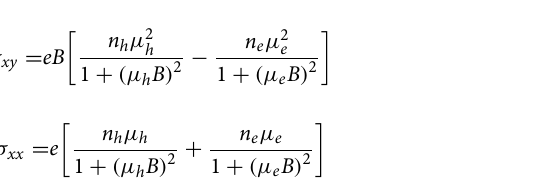
Figure 5. ( a ) The percentage magneto-resistance MR% vs magnetic field B at various temperatures for S0 film. 4 K showing the WAL effect. ( b ) Violation of Kohler’s rule The inset shows the data at low magnetic fields at T = indicating the presence of multiple scattering mechanism. The inset shows the power-law B m fitting of the MR 20 K with m 1.81 data at T = =